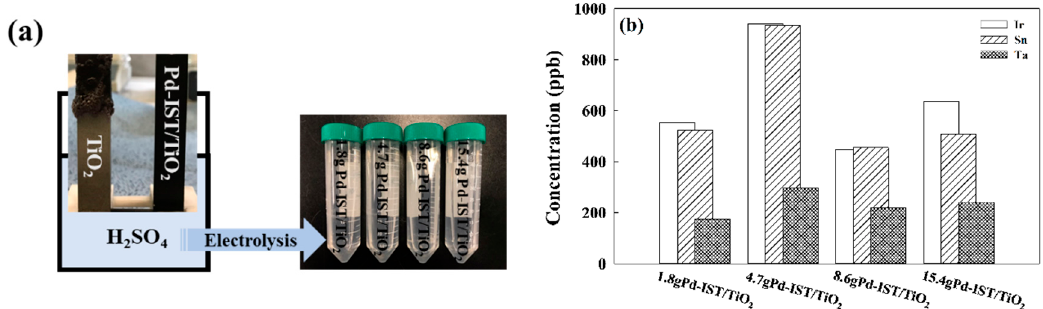
Figure 5. ( a ) The scheme of the accelerated life test; ( b ) The impurity concentration in 3 M of H 2 SO 4 after ALT using ICP-MS.